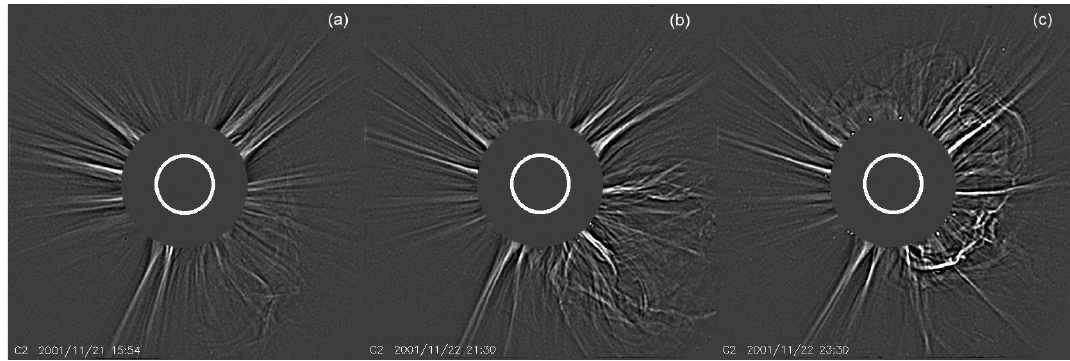
Fig. 1. Wavelet processed LASCO/C2 images of the CMEs in November 2001. (a) CME from 21 November (DOY 325), (b) first CME from 22 November (DOY 326) and (c) second CME from 22 November.